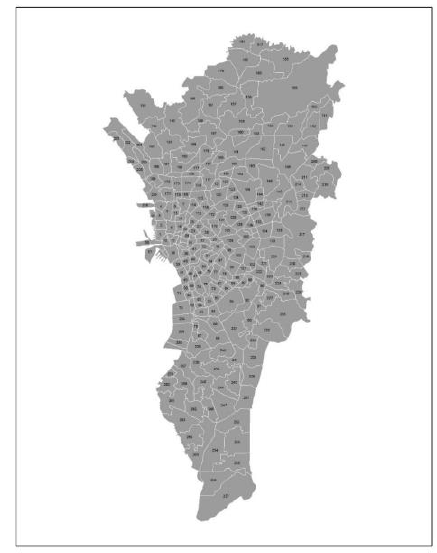
Figure 2. Traffic Analysis Zones in Metro Manila